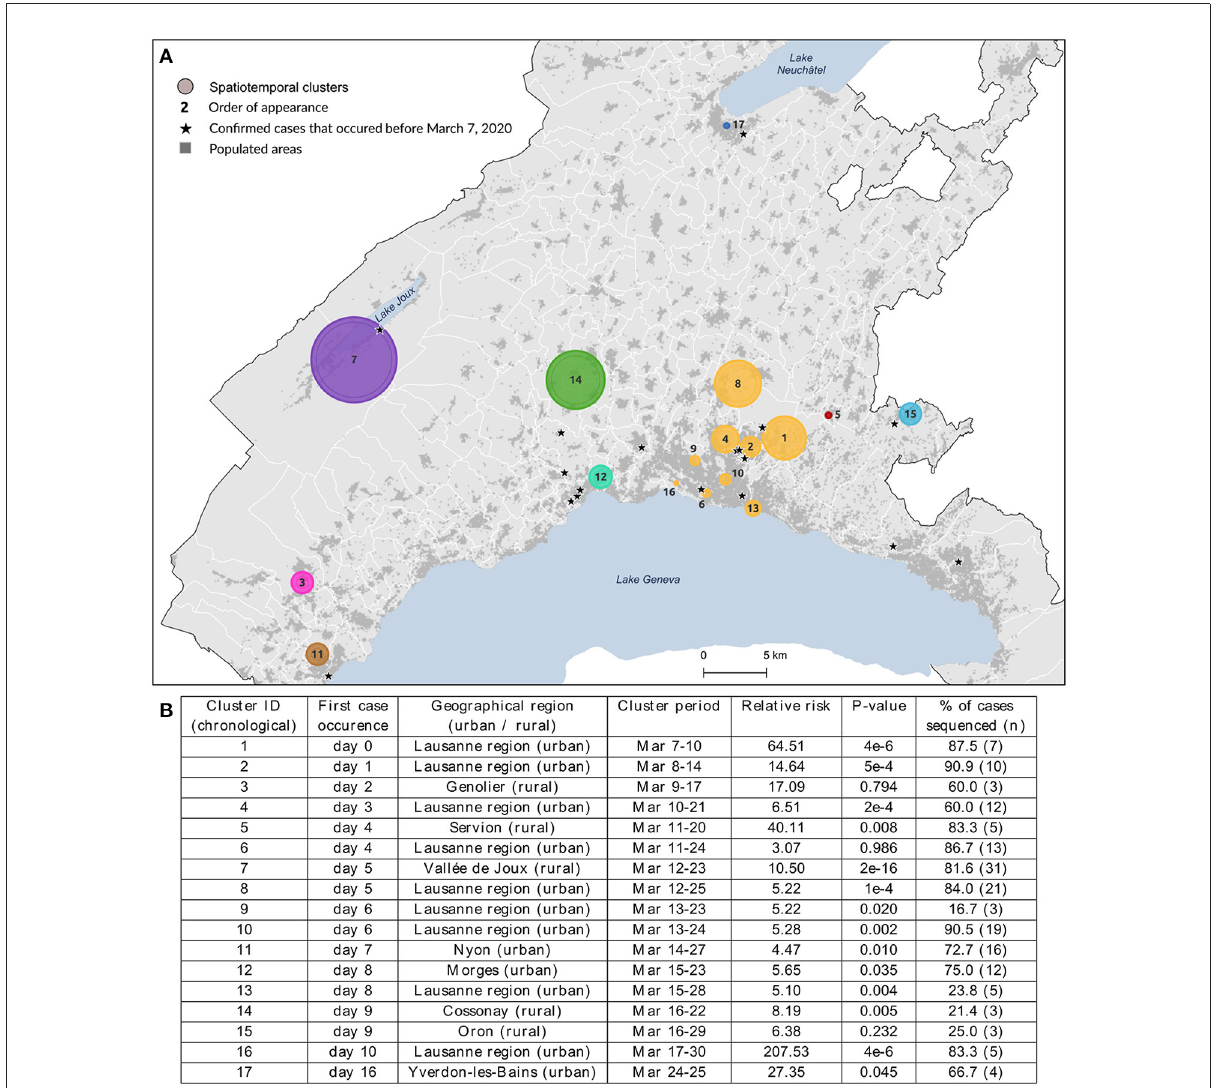
FIGURE1 Spatial distribution (A) and characteristics (B) of the 17 spatiotemporal clusters considered for genomic data analysis. These clusters were identified using a space-time scan statistic run daily from March 2 to June 30 and implemented with SaTScan version 9.6.1 (43). Characteristics include each cluster identifier with its corresponding geographical region, cluster period, relative risk of becoming infected to COVID-19 within the cluster compared to outside, significance evaluated with 999 Monte-Carlo permutations, and the proportion of sequenced cases within cluster. Clusters are colored according to the geographical region to which they